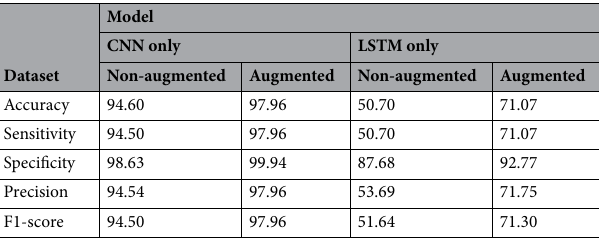
Table 5. Ablation study using different model architectures.